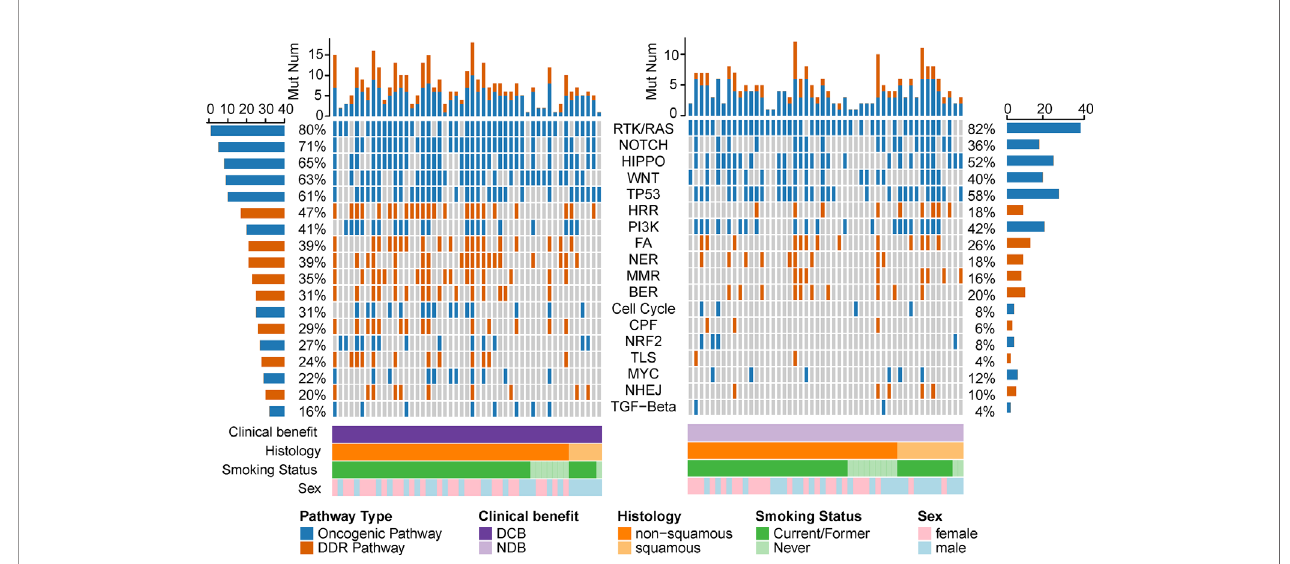
FIGURE 1 | Pathway alterations in NSCLC with or without ef fi cacious immunotherapy. Stacked plot showed the number of mutated pathway (histogram, top). Clinical characters are listed at the bottom of the fi gure. The prevalence of mutated pathways was calculated at left (in DCB group) and right (in NDB group). Orange represents the oncogenic pathway and blue stands for the DDR